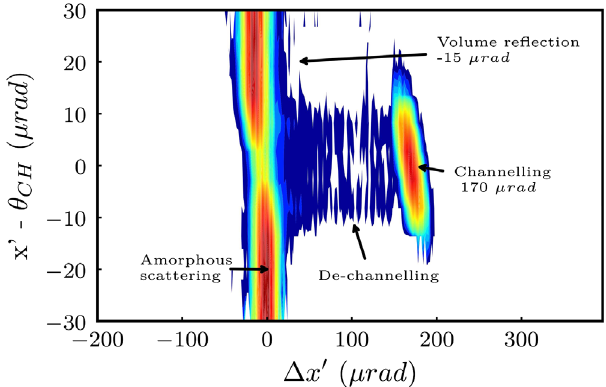
FIG. 5. Intensity crystal response as a function of both deflection angle of the crystal and incoming angle, as measured by the UA9 collaboration